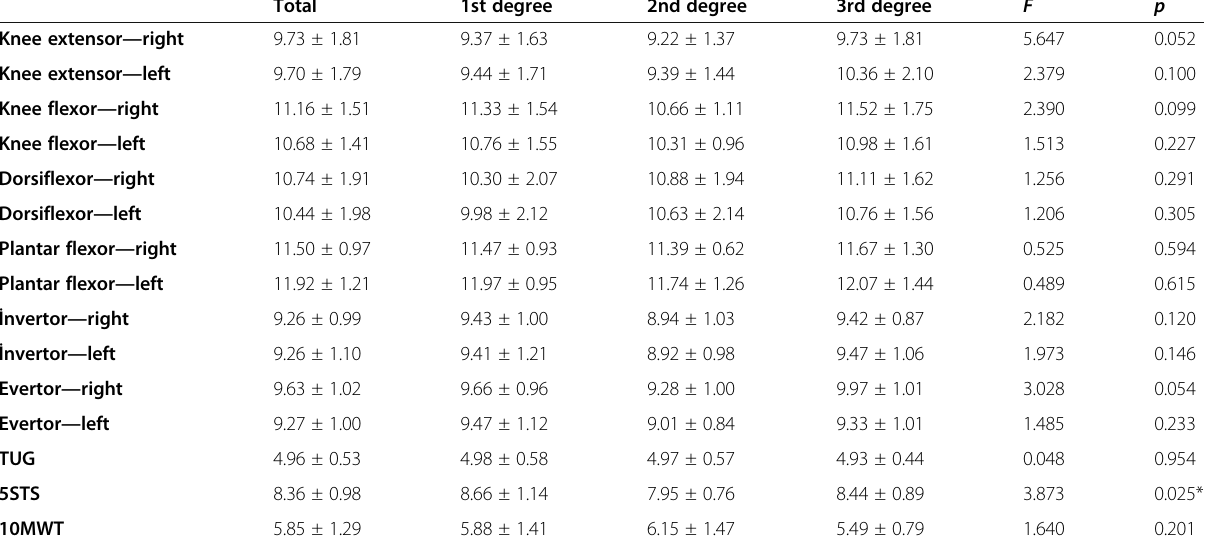
Table 2 Absolute values of the measurements and one-way analysis of variance (ANOVA) between pes planus groups